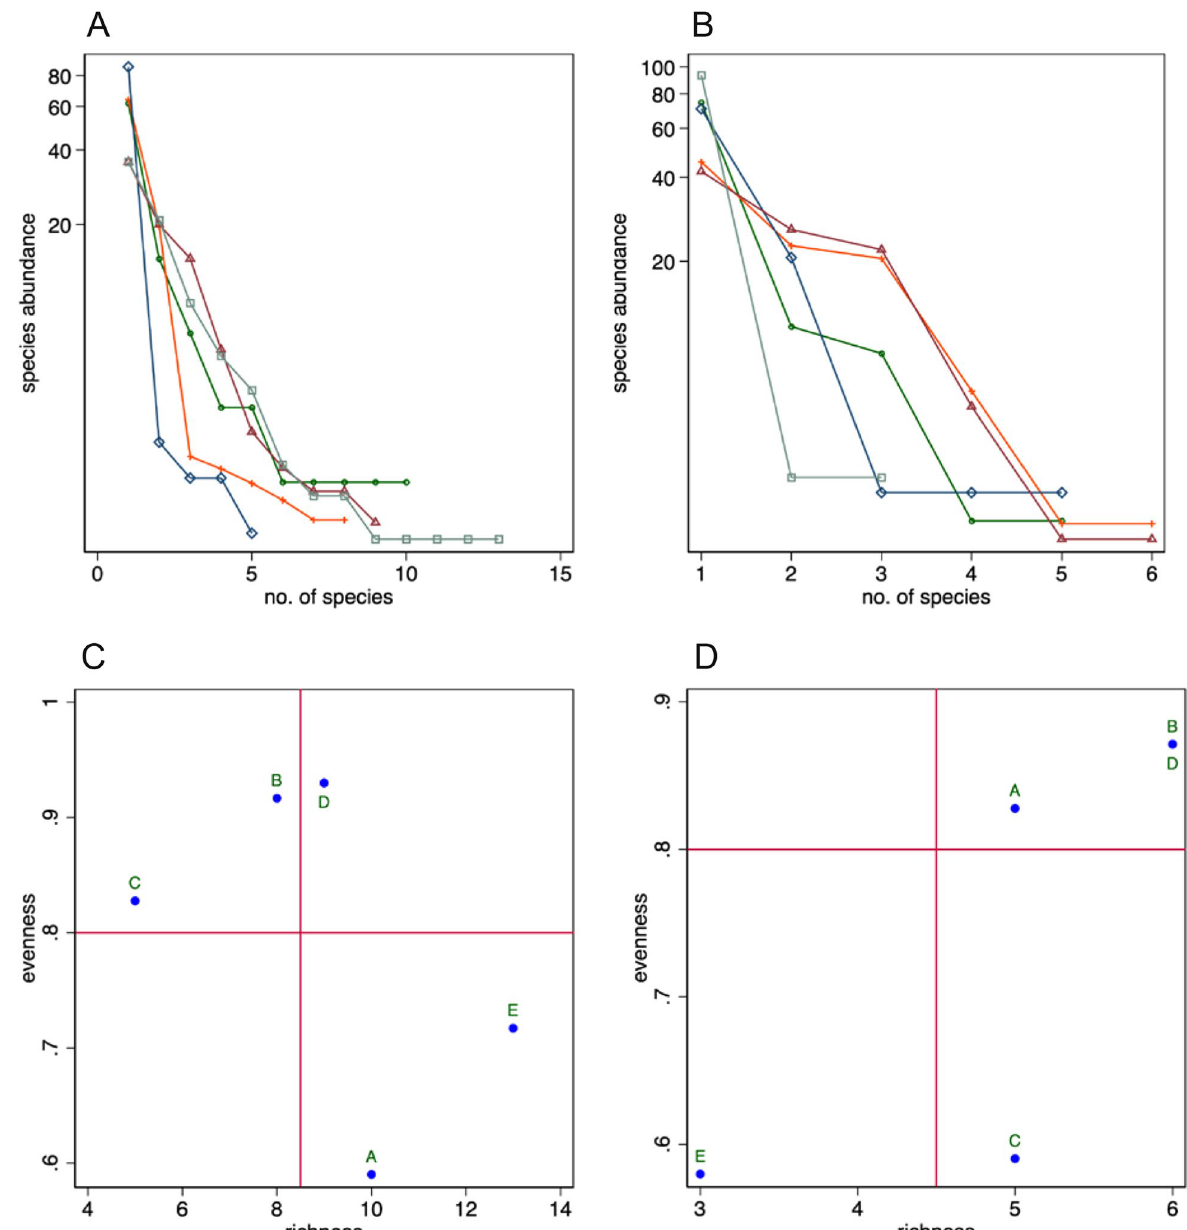
Fig. 2 Analysis of the ecological data collected by cultural methods and metabarcoding. In A and B , green circles indicate cellar A (Bolla and Carassina), orange ticks cellar B (Bresciana), blue diamonds cellar C (Campo La Torba), magenta triangles cellar D (Formazzora), and grey squares cellar E (Pontino). In C and D , A – E indicate the cellars as described in Table 1. A , B Whittaker plots. The number of individuals of each OTU are sorted in descending order; the proportion of the total number of individuals for each species is plotted on the log scale against the OTU rank, presenting the richness of each species ranked from the most (rank 1) to the least frequent rank. The steep plots indicate communities with high dominance. A Samples studied by metabarcoding using OTUs with frequencies >1%. B Samples studied by cultural methods. C , D Plot of the evenness vs. richness data for each cellar. C Metabarcoding data, using OTUs with frequencies >1%. D Culture